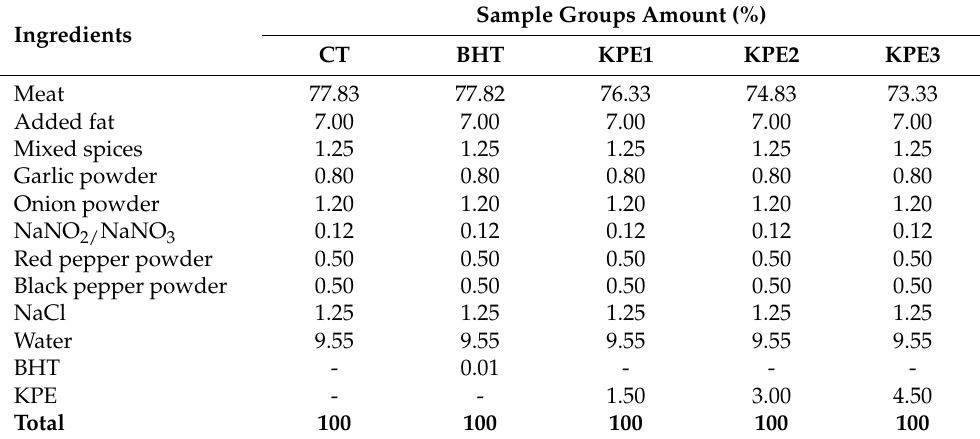
Table 1. Beef sausages